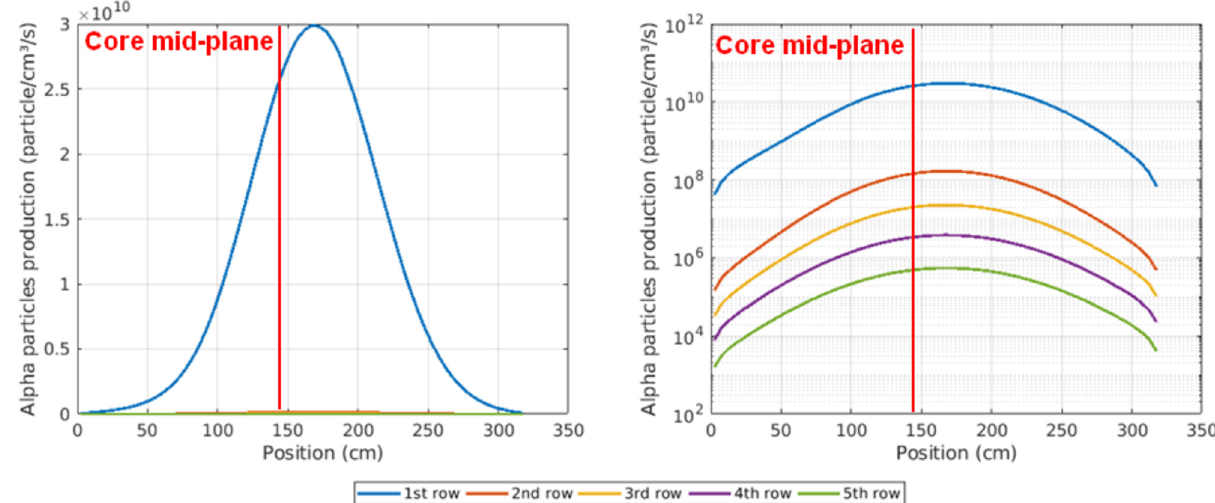
Fig. 19. Axial traverses of the production of alpha particles in the neutron shielding, linear scale (left), logarithmic scale